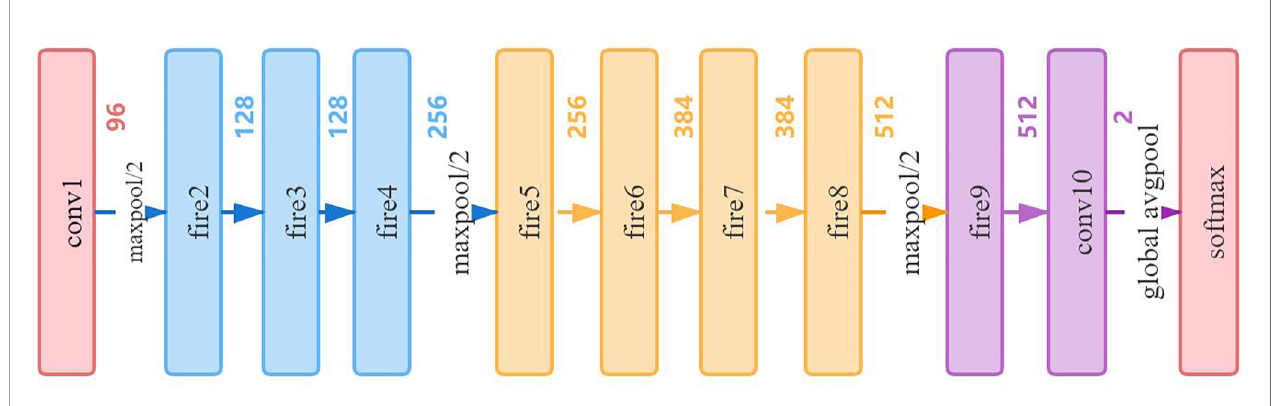
FIGURE 7 | The network architecture of SqueezeNet.